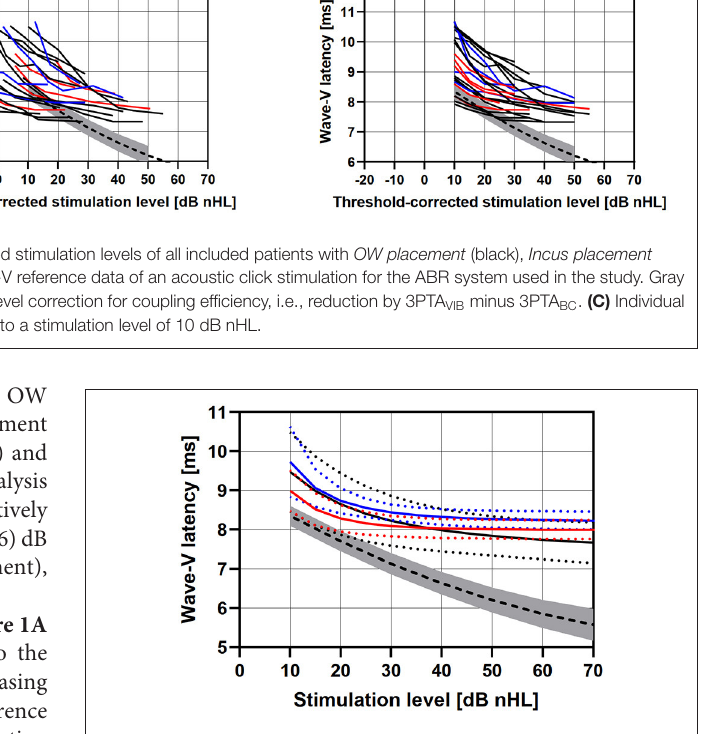
FIGURE 2 | VSB evoked ABR wave-V latencies as group averages for subgroups of OW placement (black), Incus placement (blue), and RW placement (red). Reference data for an acoustic click stimulation are shown as dashed line. The dotted lines, errors bars, and the gray area depict standard